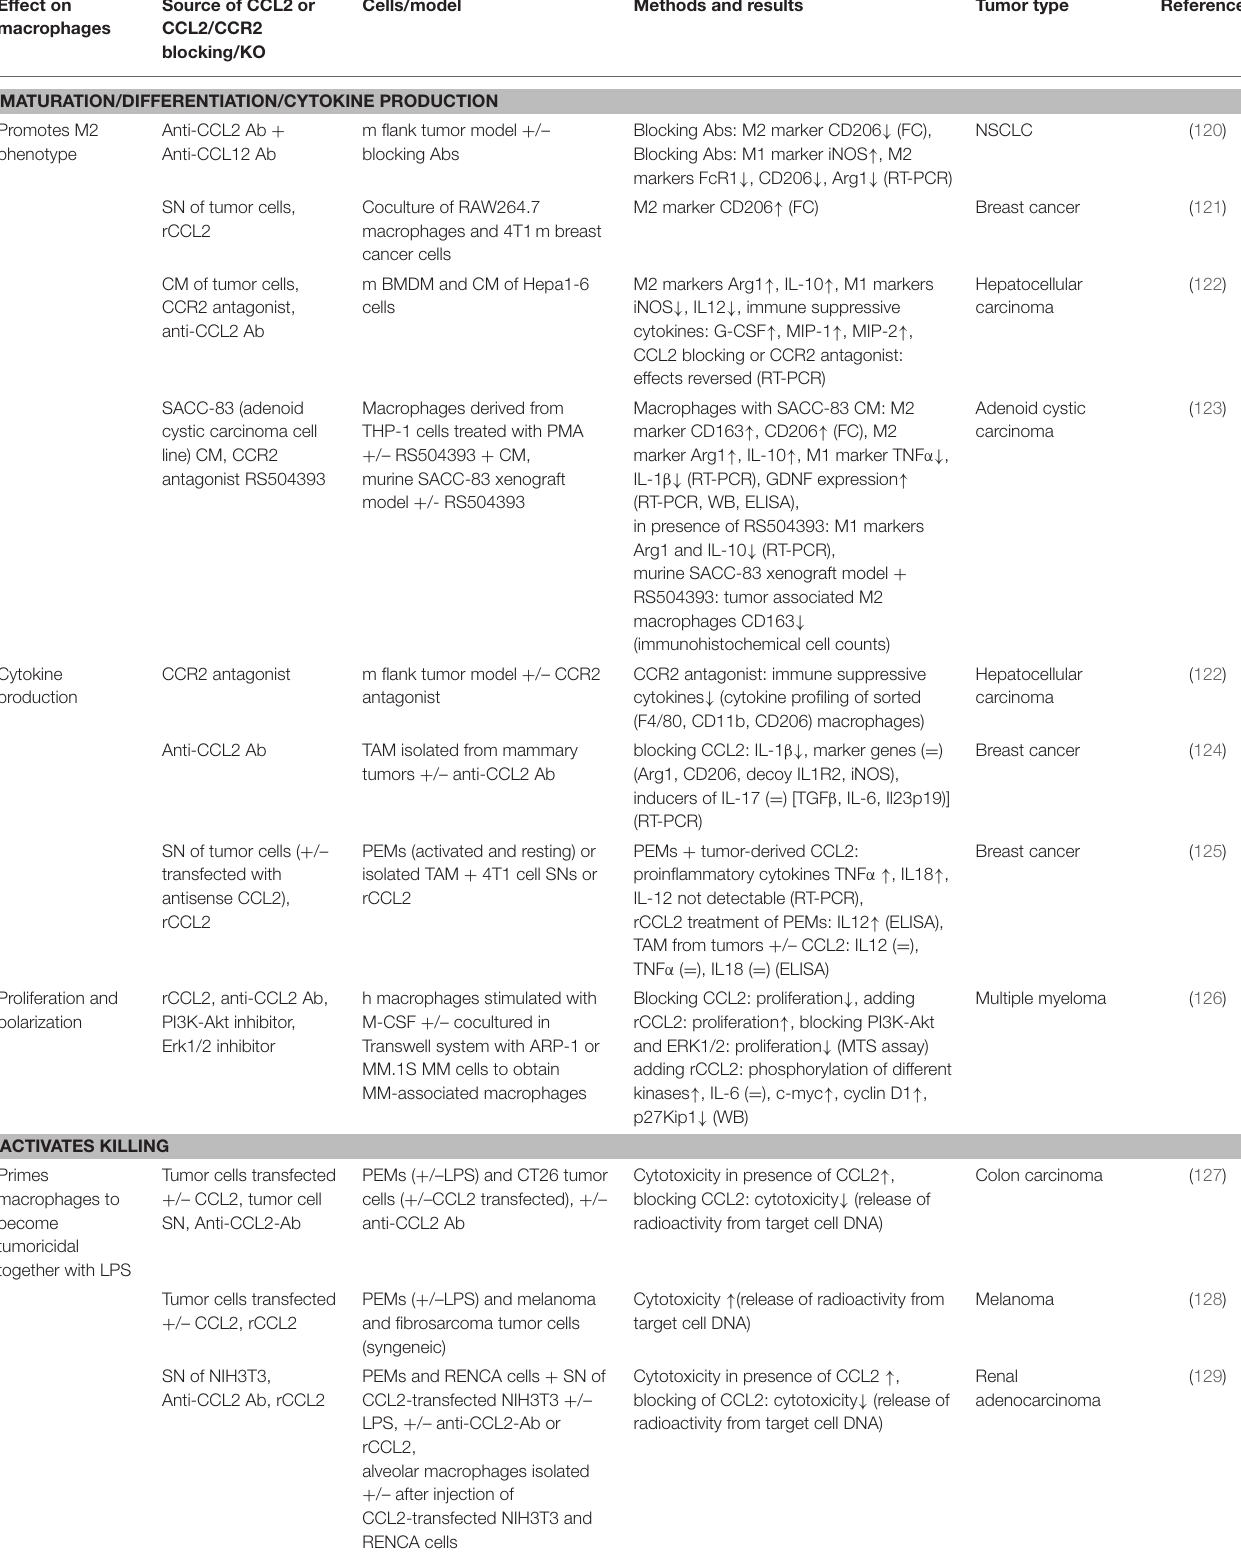
TABLE 5 | Summary of CCL2’s effects on macrophages in